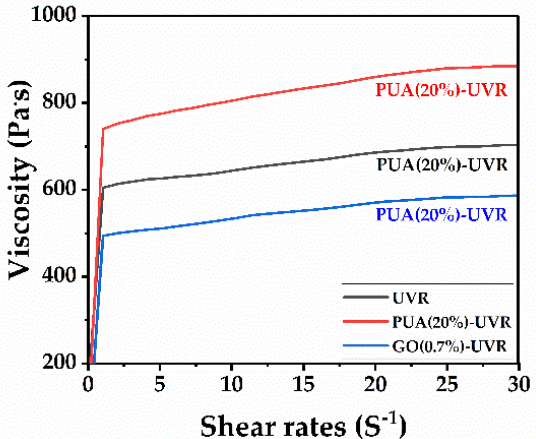
Figure 9. Viscosity relation of ( a ) free − radical/cationic hybrid, ( b ) polyurethane acrylates (20%) modified, and ( c ) graphene oxide (0.7%) modified photosensitive resins.